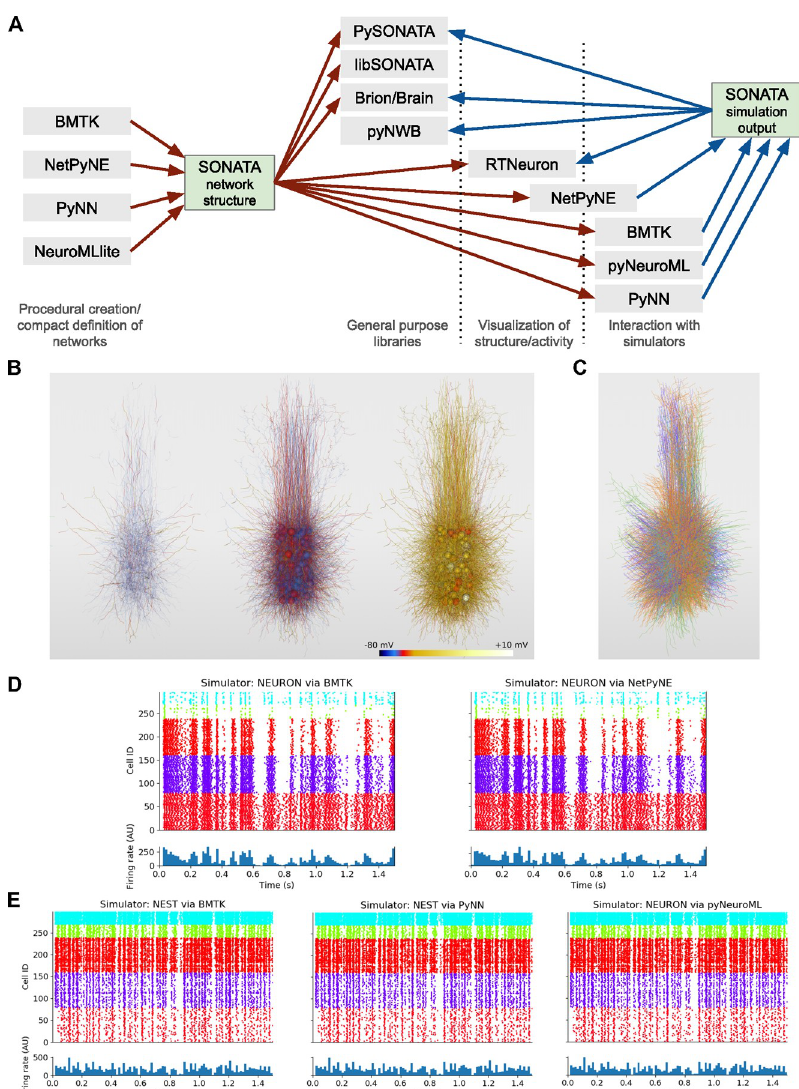
Fig 5. Support for SONATA in simulators and libraries. (A) Overview of applications which can generate SONATA files (containing either a description of a network structure or simulation output) and the various categories of applications which can read SONATA, including general purpose libraries, visualization tools, and simulation packages. The software packages BMTK, NetPyNE, PyNN, and pyNeuroML can read SONATA network descriptions for execution in the simulation engines NEURON and NEST. The pyNWB package provides a programming interface for reading and writing neurophysiology data (either from experiments or from simulations) in the NWB:N 2.0 format. (B) RTNeuron visualization. Sample renderings at 3 simulation timesteps of an example network with 300 biophysically detailed cells, with somatic and dendritic compartments colored according to the simulated membrane potential. The biophysical 300-cell network, as well as its point-neuron counterpart in (E), were created via the model- building scripting interface in BMTK and saved using SONATA. These two models are used in all subsequent panels here. (C) Rendering of the same model as in (B) using the NetPyNE GUI. Each cell is colored according to which of the 5 node types it belongs. (D) The 300-cell biophysically detailed example from (B) and (C) simulated in NEURON using BMTK (left) and NetPyNE (right). (E) A network with 300 integrate and fire neurons generated by BMTK, and simulated in NEST via BMTK (left), NEST after importing the SONATA files into PyNN (middle) and NEURON after conversion of the network to NeuroML by pyNeuroML. Each raster plot in (D) and (E) is accompanied by a panel underneath showing population firing rate (arbitrary units).